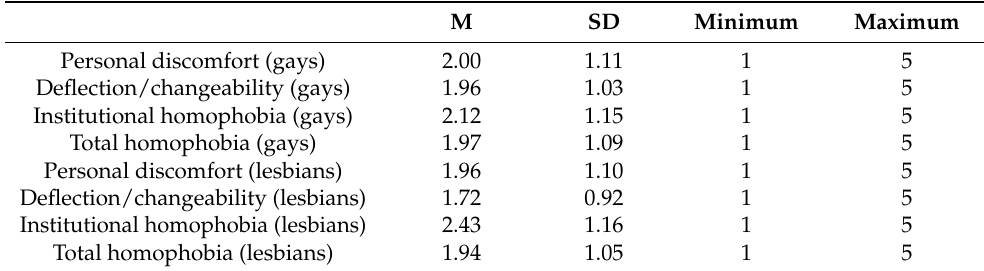
Deflection/changeability (lesbians) 1.72 Institutional homophobia (lesbians) 2.43 Total homophobia